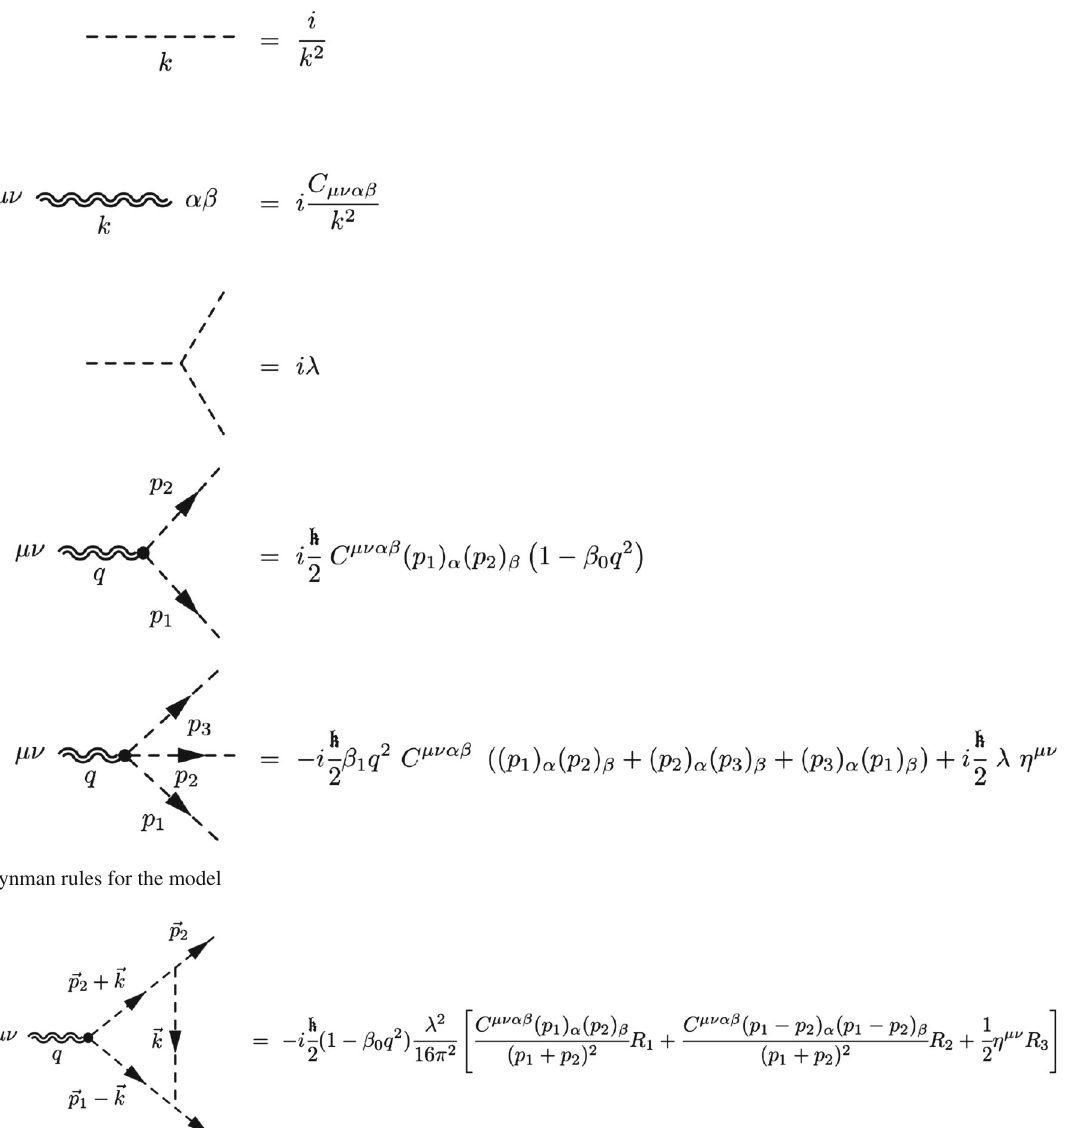
Fig. 4 Feynman rules for the model